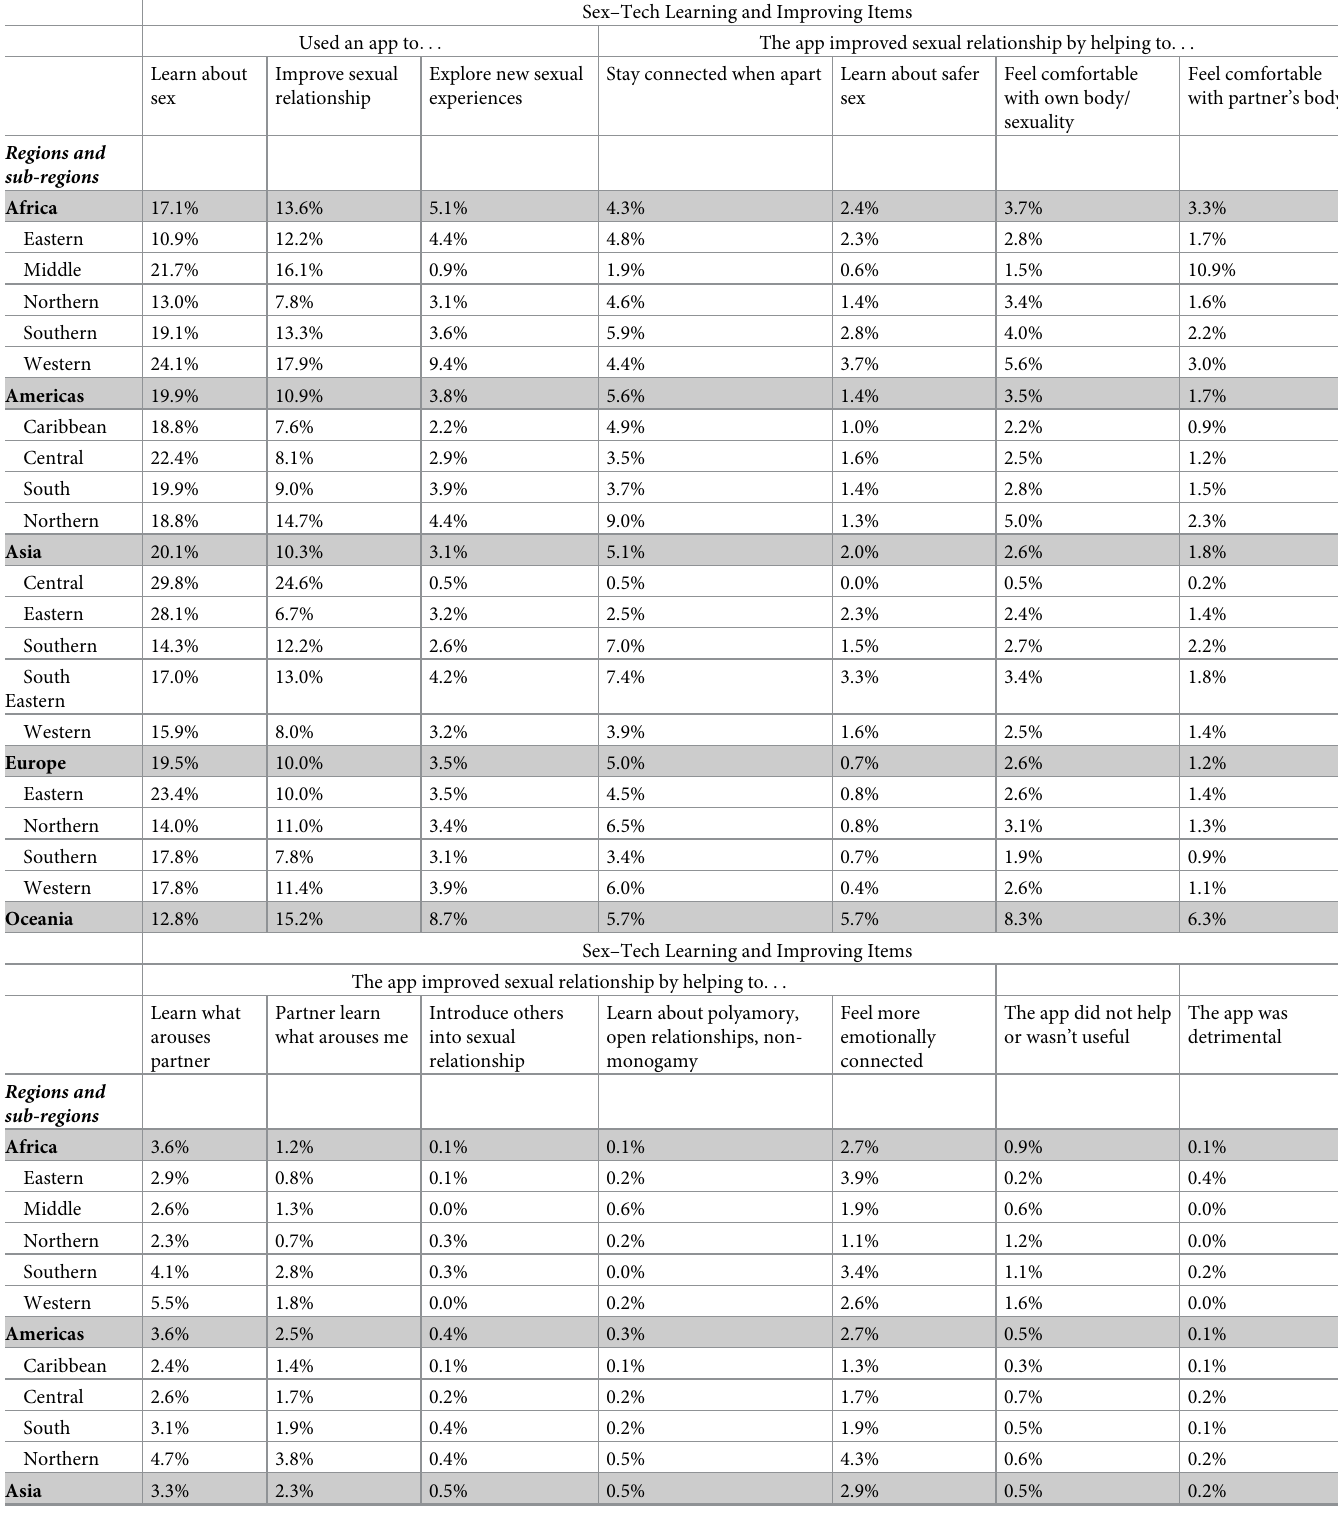
Table 3. Frequencies of those selecting “yes” to all items relating to learning and improving, by UN-designated regions and sub-regions. Sex–Tech Learning and Improving Items Used an app to